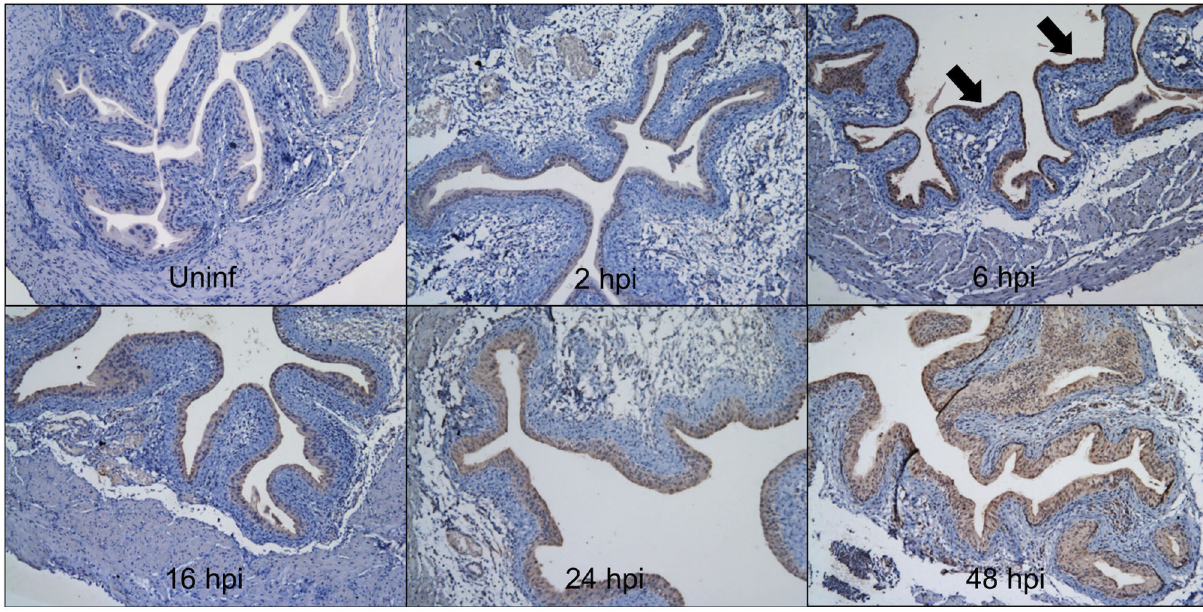
Figure 5. Bladder mBD-14 protein expression is induced by UPEC infection. Naïve and infected bladders harvested at indicated hpi were subject to mBD-14 IHC and counterstained with hematoxylin. Whereas mBD-14 is undetectable in uninfected bladder, it is expressed throughout the urothelium as early as 2 hpi, with increased expression by 6 hpi (black arrows) that persists at subsequent timepoints. 100x